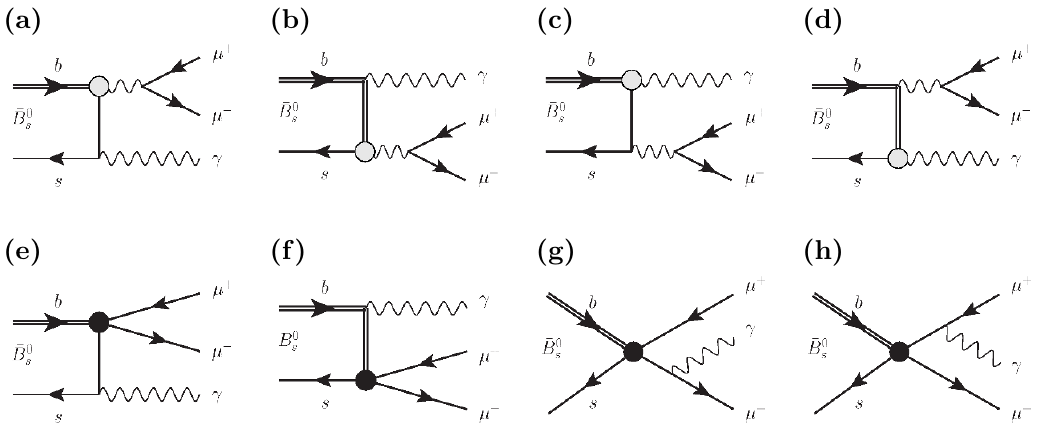
Figure 1 . Short-distance diagrams contributing to the (cid:22) B 0 ! (cid:22) + (cid:22) (cid:0) (cid:13) process to lowest order. The s 0 ) black and the grey circles denote the insertion of the four-fermion operators O ( and respectively 9 ; 10 0 ) of O ( . The form factors T ( q 2 ; 0) and T (0 ; q 2 ) describe the diagrams ( a; b ) and ( c; d ) respec- ? ; k ? ; k 7 tively. Diagrams ( e ) and ( f ) are described by the V ( q 2 ) form factors and diagrams ( g ) and ? ; k ( h ) encode bremsstrahlung contributions, whose hadronic matrix elements are described by the (cid:22) B 0 s decay